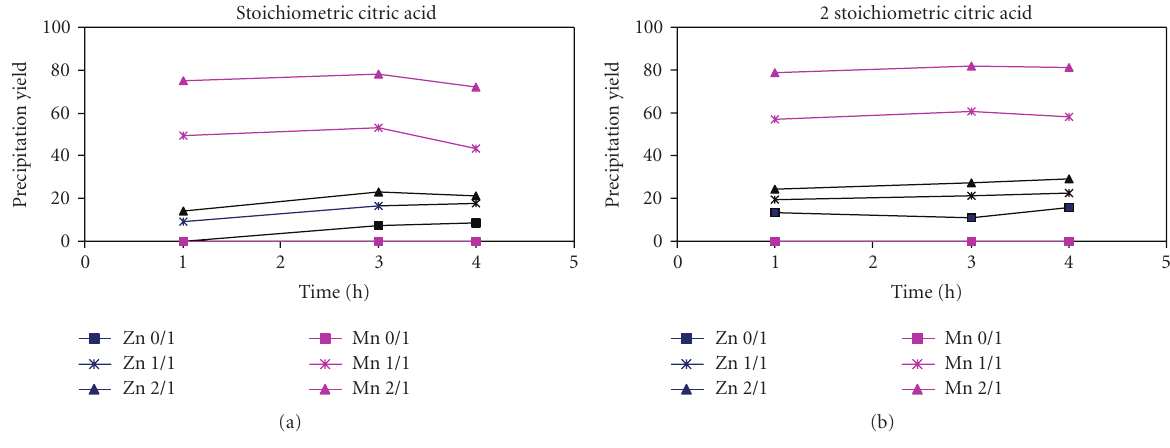
Figure 6: Precipitation trend of Zn and Mn in the first series of precipitation tests.